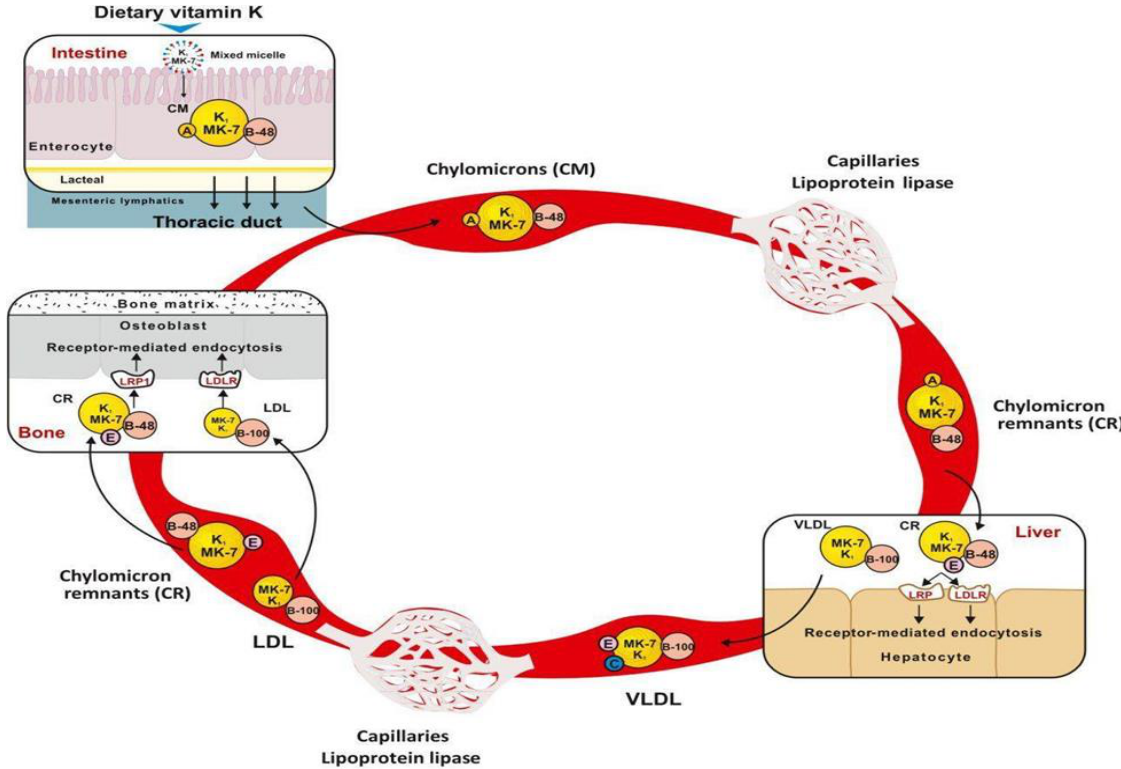
Figure 2. Schematic diagram of dietary phylloquinone (K1) and menaquinone-7 (MK-7) absorption, transportation, and cellular uptake (8)